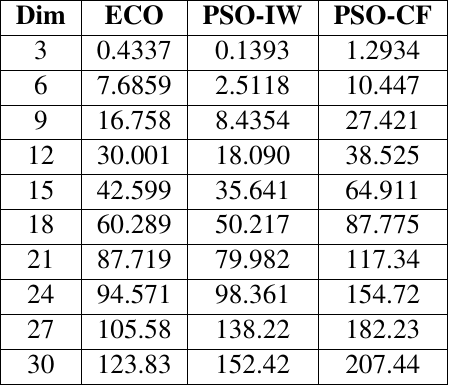
Table 8: Results on Rastrigin function from 3 dimensions to 30 dimensions Dim ECO PSO-IW PSO-CF